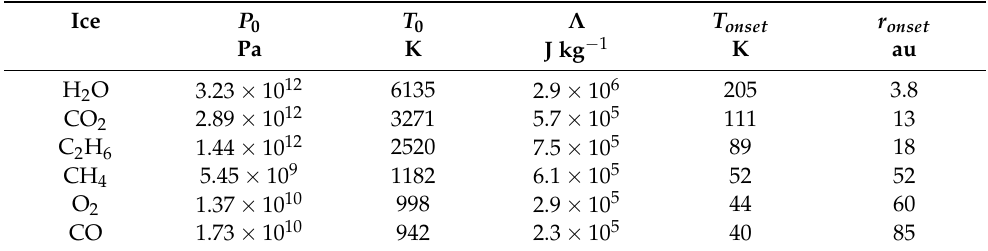
Table 2. Ice parameters